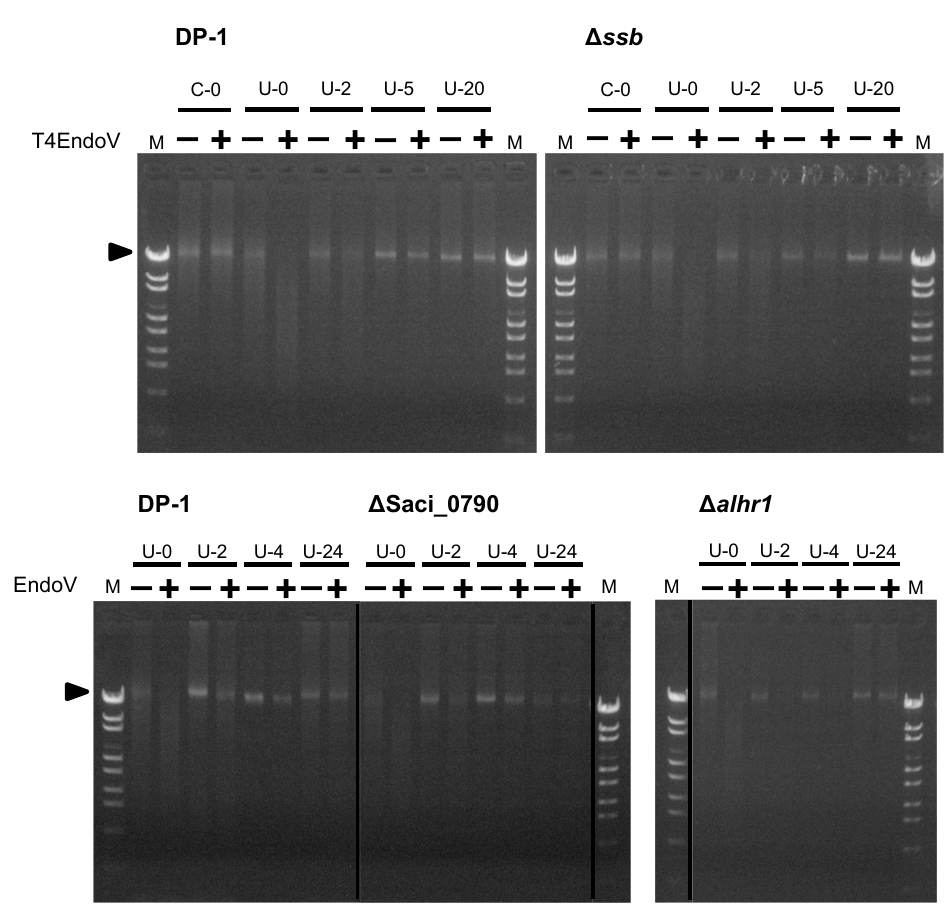
Figure 4. Analysis of the DNA repair capacity of cyclobutane pyrimidine dimers (CPDs) in ∆ ssb , ∆ alhr1 , and ∆ Saci_0790. The genomic DNA isolated from mock-treated (C-0) and irradiated cultures of each strain at each time point (U-0–24, where numbers mean cultivation time [hours] after UV irradiation [1200 J/m 2 ]) was cut with T4 EndoV (lane +) or mock-treated (lane − ). The genomic DNA was denatured followed by loading on a 1% agarose gel stained with ethidium bromide. The arrow indicates the position of the bands containing uncut genomic DNA.